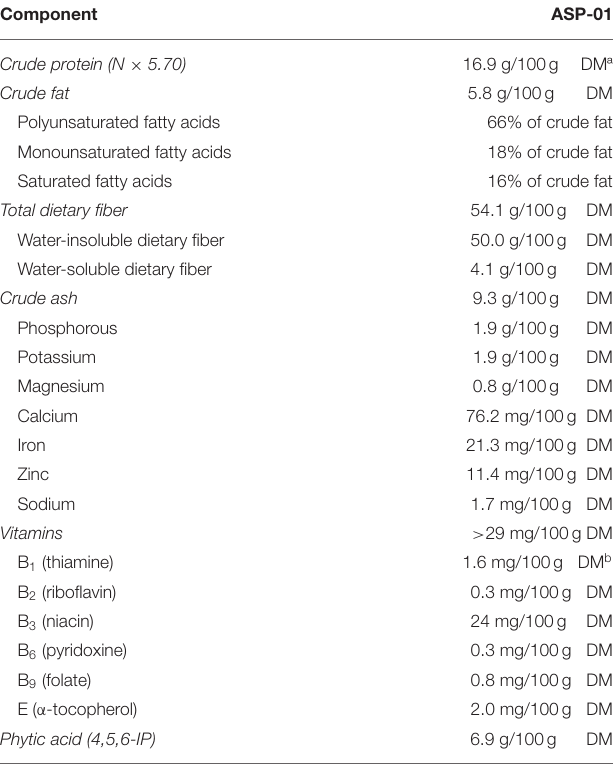
TABLE 1 | Overview of the composition of aleurone standard preparation 1 (ASP-01) in grams or milligrams per 100g dry matter (DM) [adapted from Buri et al.